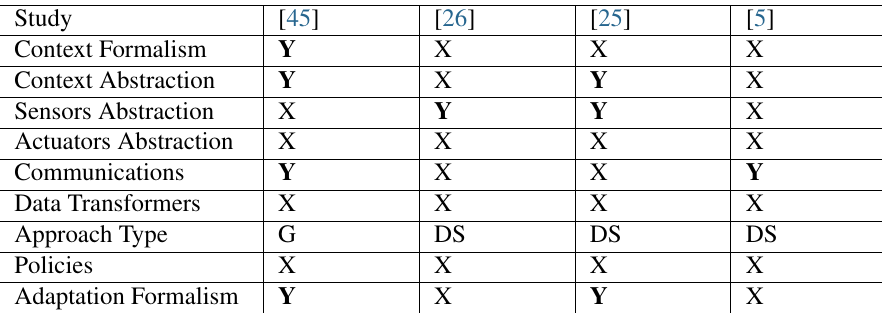
Table 8. Comparison Between Context-Aware Approaches Part-1